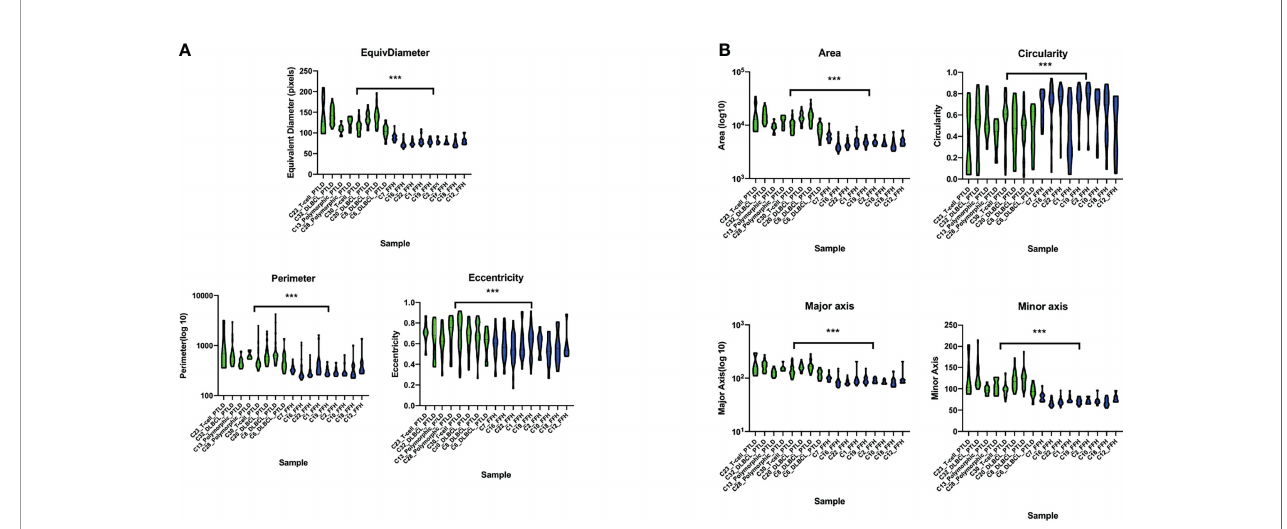
FIGURE 8 | Violin plot of the digital imaging analysis of M-PTLD, P-PTLD, CHL-PTLD, and FFH-PTLD cases. (A) Violin plots of cellular parameters of equivalent diameter, perimeter and eccentricity. (B) Violin plots of cellular parameters of area, circularity, major axis, and minor axis. Displayed are nine representative samples of each group. Green represents M-PTLD and P-PTLD cases, blue indicates FFH-PTLD cases. (***) = statistical signi fi cance